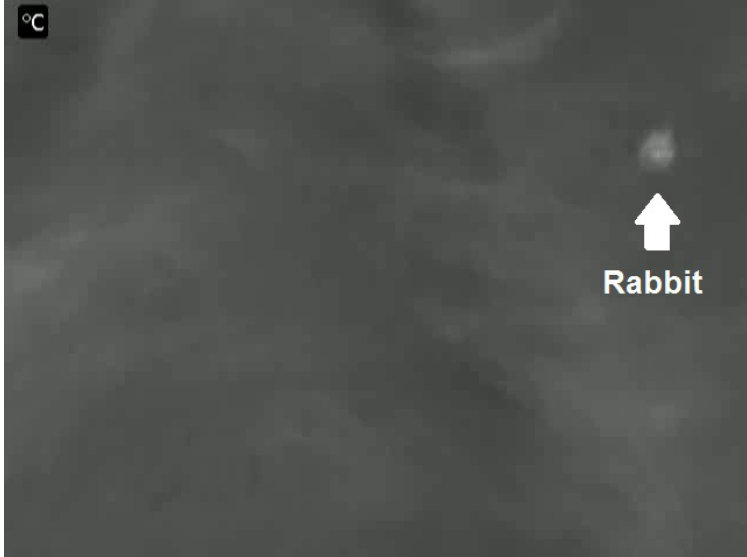
Figure 2. A single frame from video recording of rabbit at 4 km/h. The rabbit appear brighter than the background on the thermal image. The somewhat higher temperature in the wheel tracks can also be